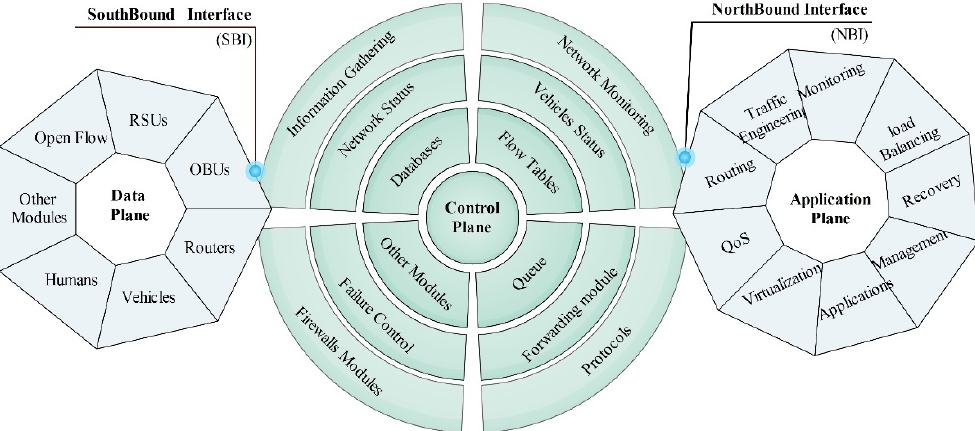
Figure 2. The three planes of the software defined network (SDN) architecture (data plane, control plane, and the application plane).